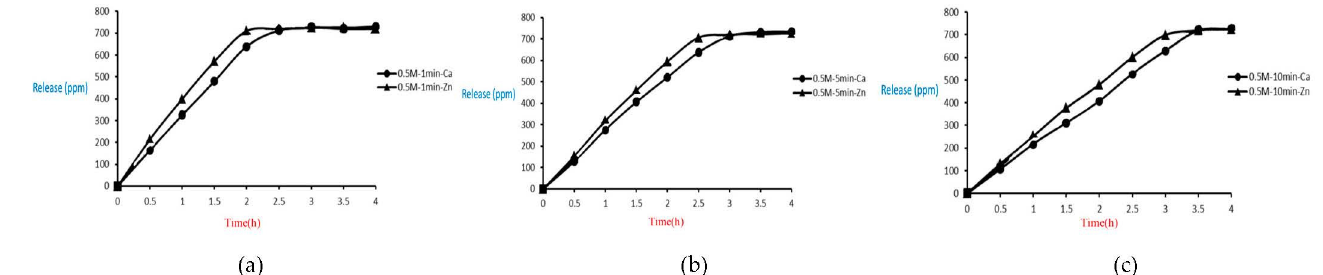
Figure 25. The effect of different cross-linking reagents (0.5 M, cross-linking time of 1 ( a ), 5 ( b ), 10 ( c ) minute) on releasing of tea tree essential oil from alginate/tea tree essential oil microcapsules in the hot.